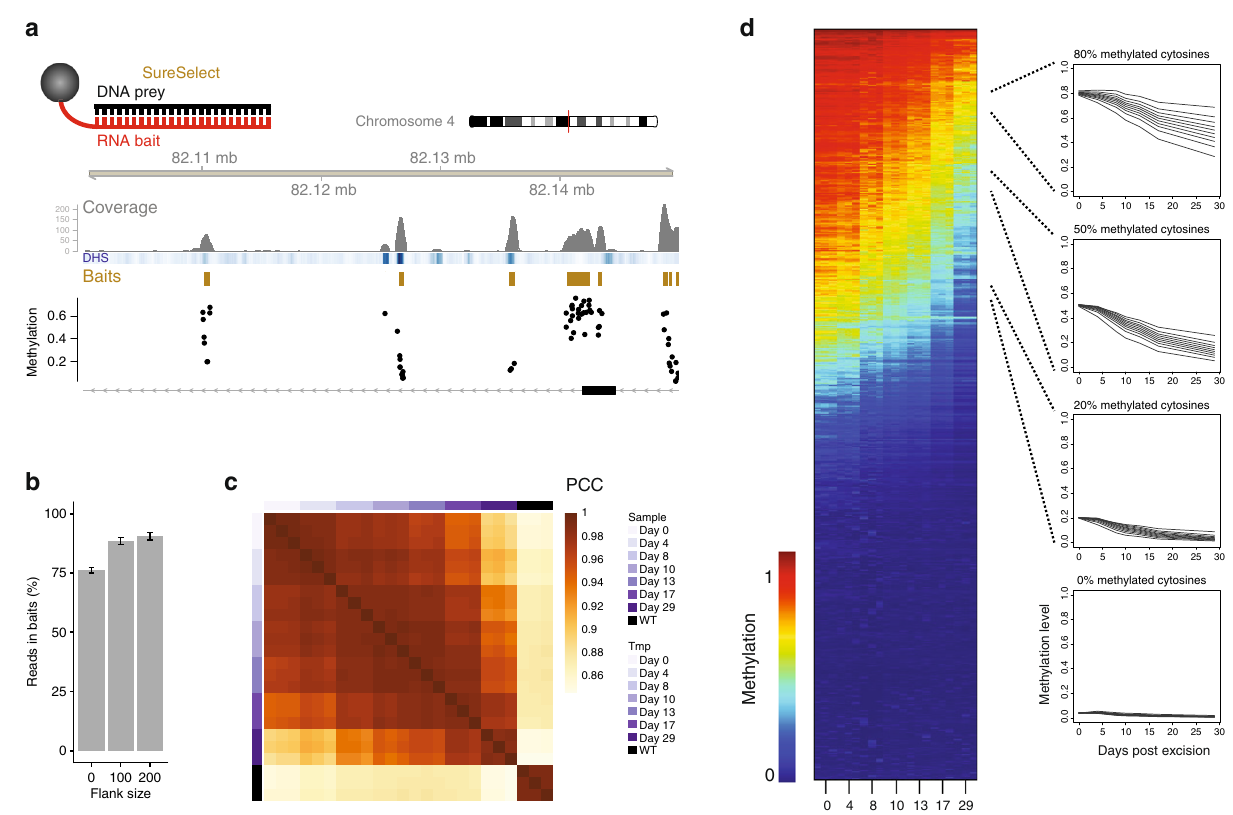
Fig. 3 Genome-scale measurement of methylation kinetics. a Outline of the SureSelect strategy (above) and a browser screenshot of raw read counts, DHS signal (blue), bait design regions (gold), and CpG methylation level measured prior to induced deletion (black dots). b Percentage of reads in libraries mapping to bait regions. Bars represent bait region boundary extension by 0, 100, or 200 bp, respectively. Error bars represent two standard deviations from the mean of three replicates. c Hierarchical clustering of methylation levels for all samples measured. Annotation column and row depicts days post transduction and wild-type samples. PCC is the Pearson correlation coef fi cient. d Decay of methylation over time for 2.1 million CpGs. Color scale is as in Fig. 1e, dark red representing 100% methylated CpGs and dark blue representing 0% methylation. Traces to the right represent average pro fi les of CpGs with similar steady states (noted above panels) but different decay kinetics. CpGs with steady states of 20, 50, and 80% (±2%) were separated into decile bins based on k de and average pro fi les from these bins are